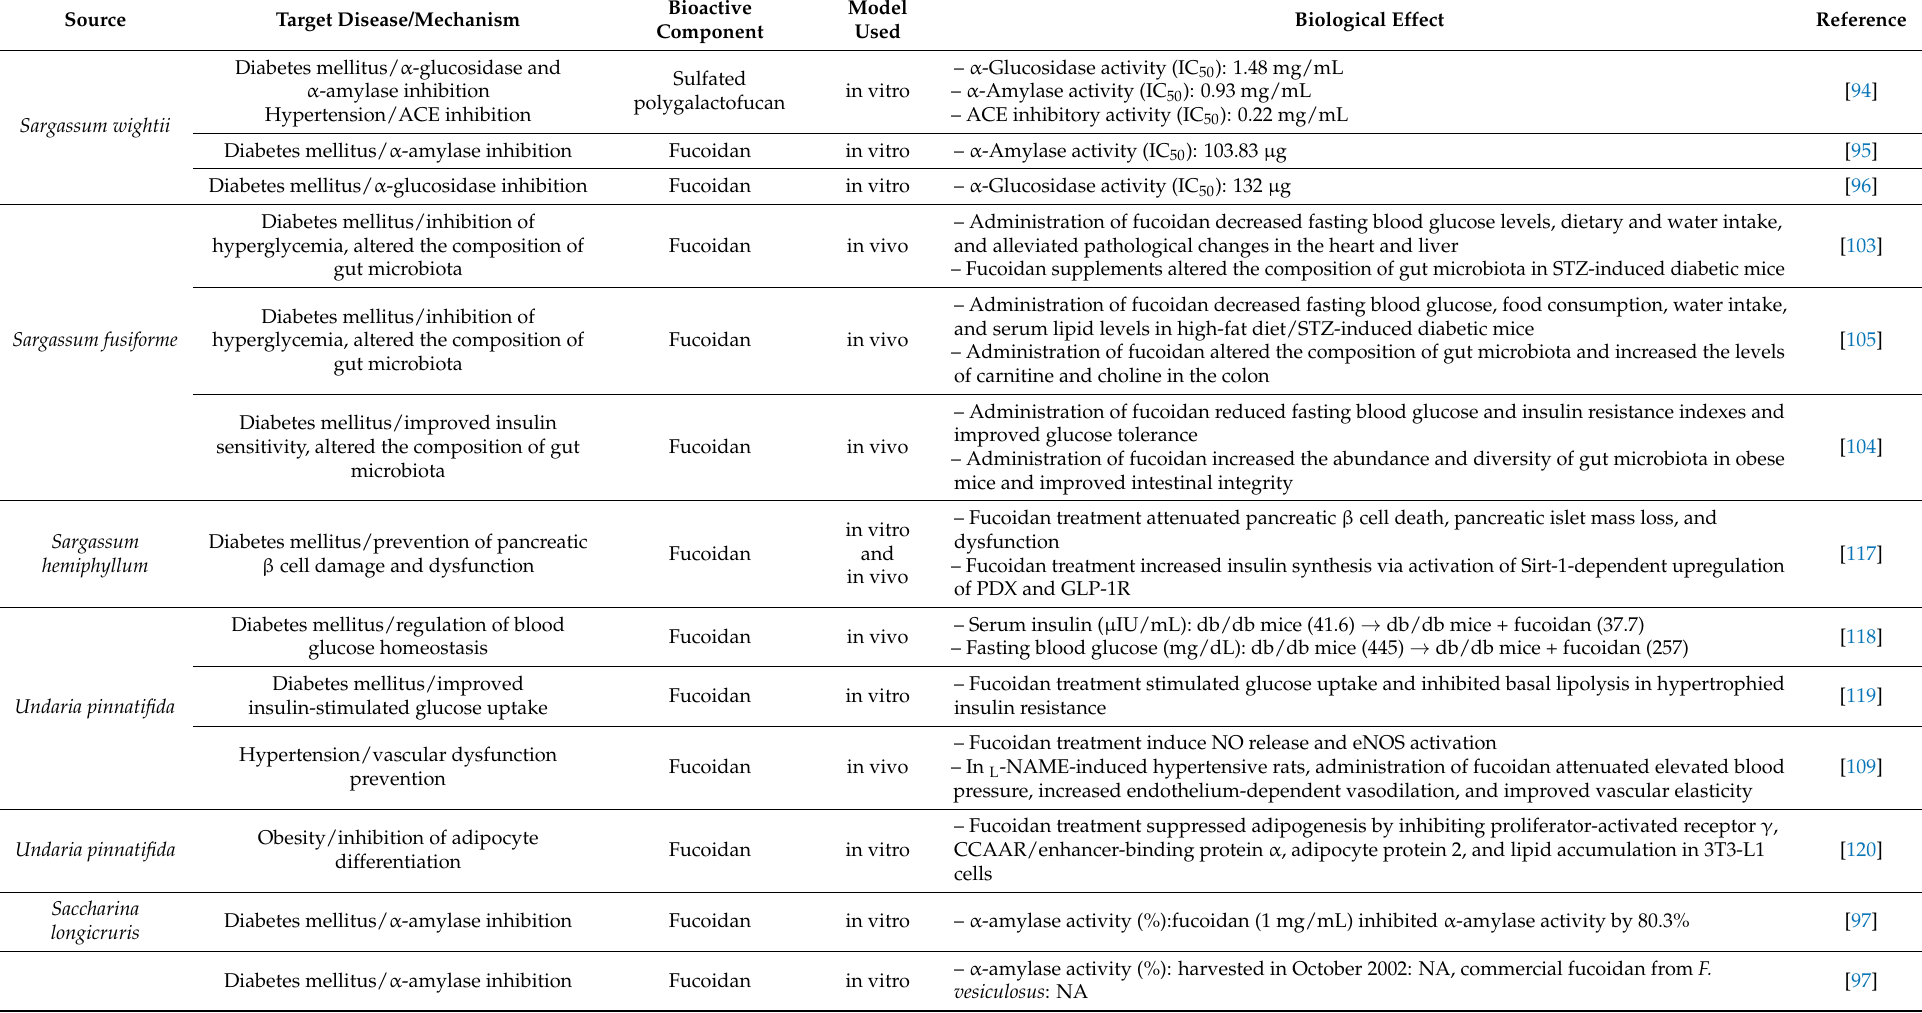
Table 2. Polysaccharides isolated from seaweeds with therapeutic potential against cardiovascular